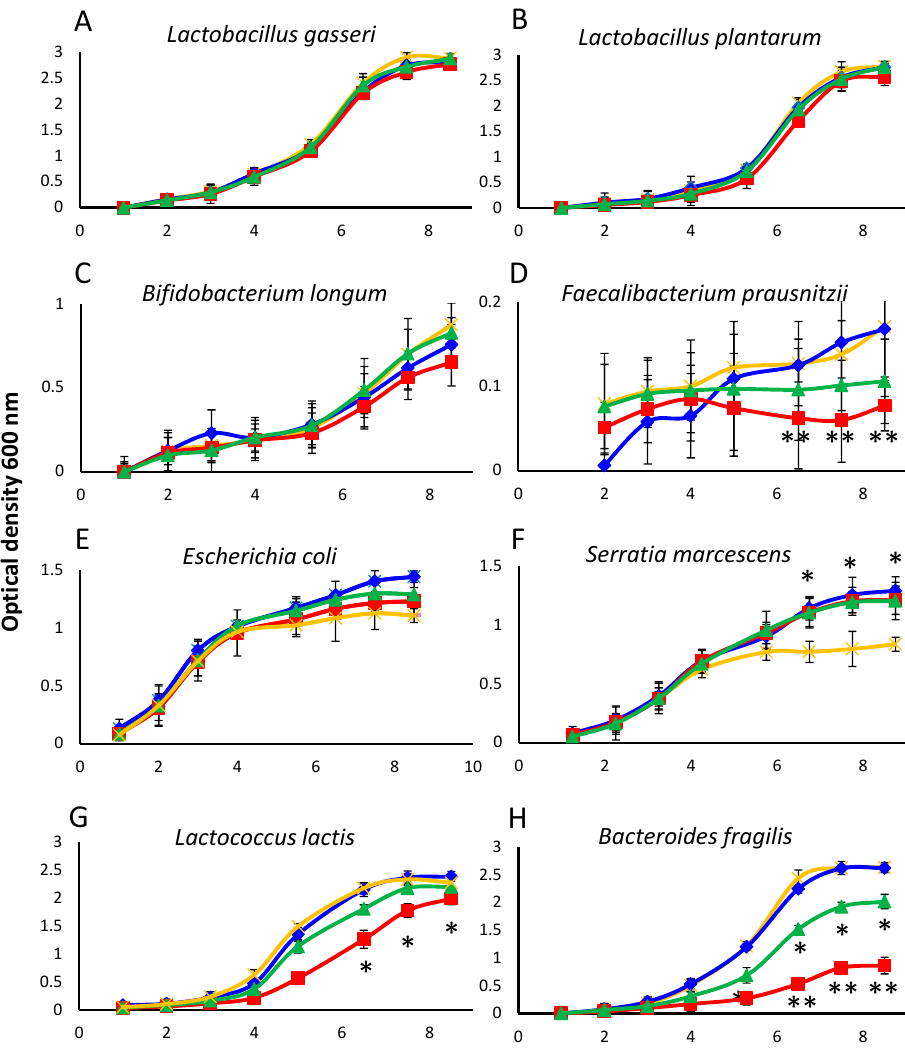
Figure 1. Growth curves of representative strains ( A – H ) as an average of the optical density (OD) measures of triplicate cultures in the presence of the soy isoflavone aglycones daidzein (in blue) and genistein (in red), and the daidzein-derived metabolite equol (in green) (all at 32 μ g mL − 1 ), as compared to a control without additives (in orange). Note that OD scale is different for different species. Mean values were compared by the Student’s t -test. Vertical bars show standard deviations (SD). Statistical significance: * p ≤ 0.05, ** p ≤ 0.01.